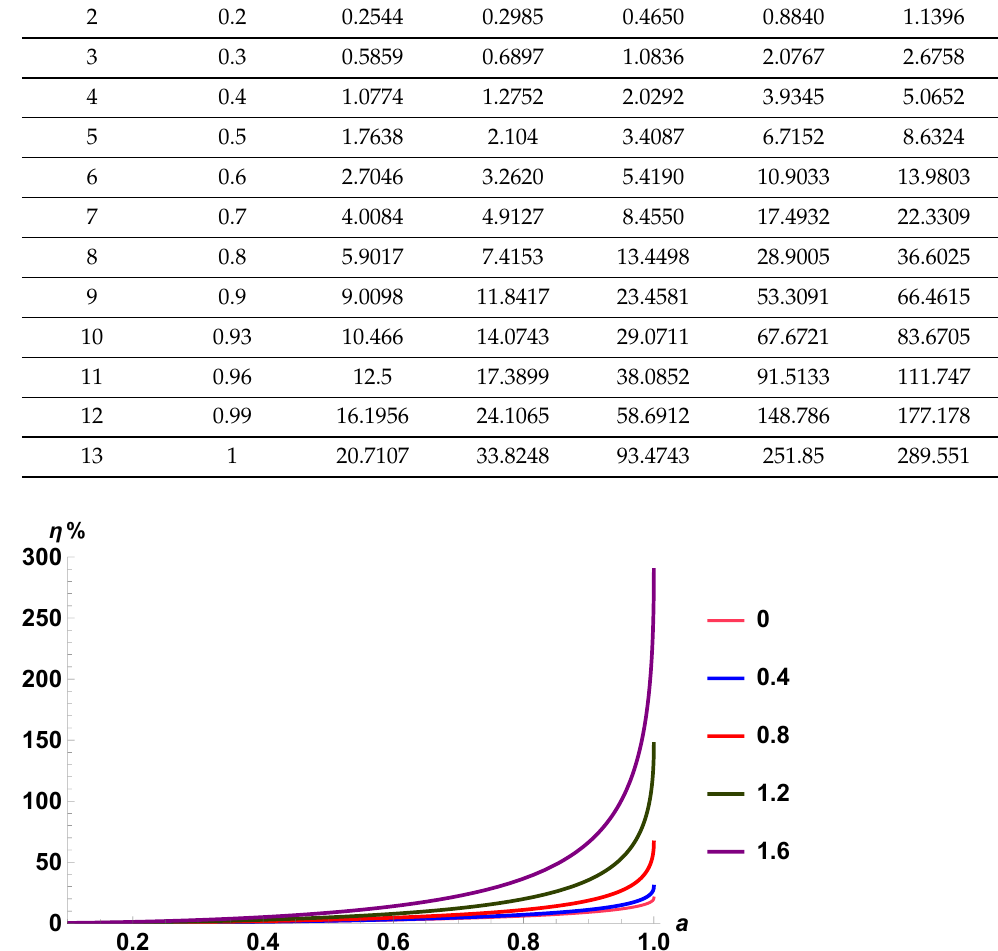
Figure 4. Energy extraction efficiency vs. spin parameter for a singular black hole. The bar on the right side of the page beside the figure represents the values of the regularisation parameter l , where l = 0 for the Kerr black